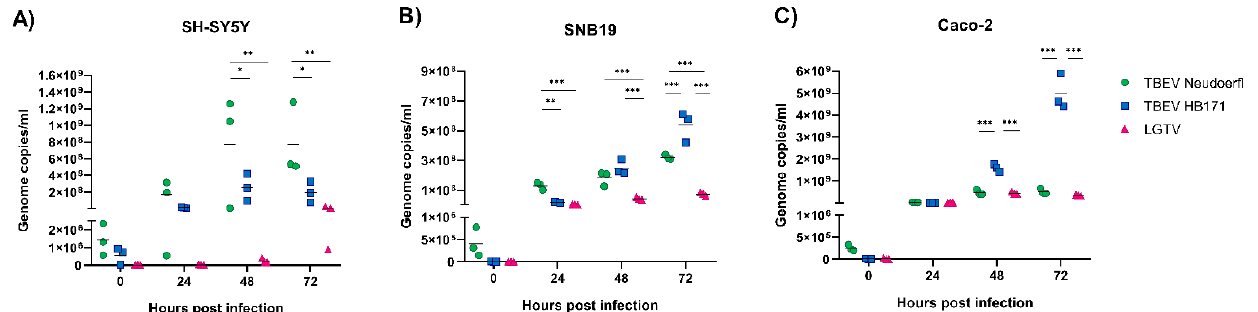
Figure 1. Comparison of the replication efficiencies of the different tick-borne flaviviruses in neuronal ( A ), astrocyte ( B ) and intestinal ( C ) cell lines. Cells were infected at multiplicity of infection of 0.1 and supernatants were collected at 0, 24, 48 and 72 h post infection. Viral RNA was extracted from culture supernatants and quantified by qRT-PCR. Genome copy numbers of Neudoerfl are shown in green, HB171 in blue and LGTV in pink. All infections were performed in triplicates and repeated three times. Statistical analyses were performed by 2-way ANOVA with Tukey’s multiple comparison test, * p < 0.033, ** p < 0.002, *** p < 0.001 .